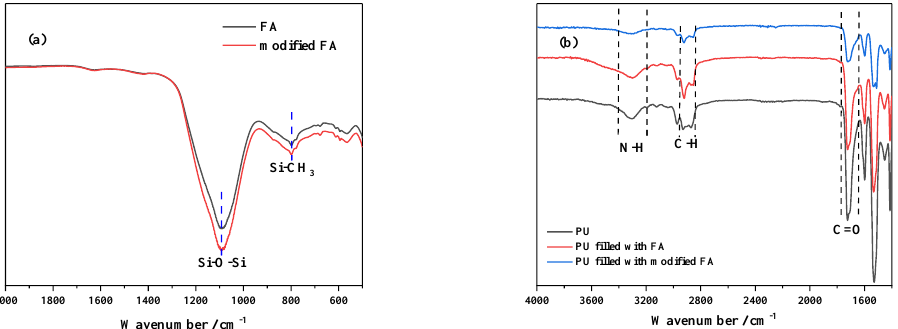
Figure 2. Fourier transform infrared spectroscopy (FT-IR) analysis of FA and modified FA ( a ); PU, PU filled with FA and PU filled with modified FA ( b ).